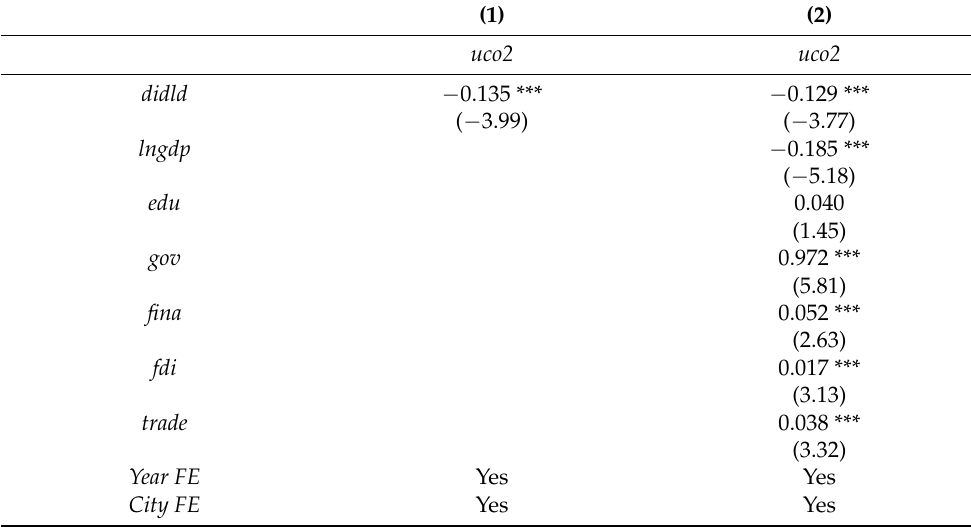
Table 8. Policy linkage